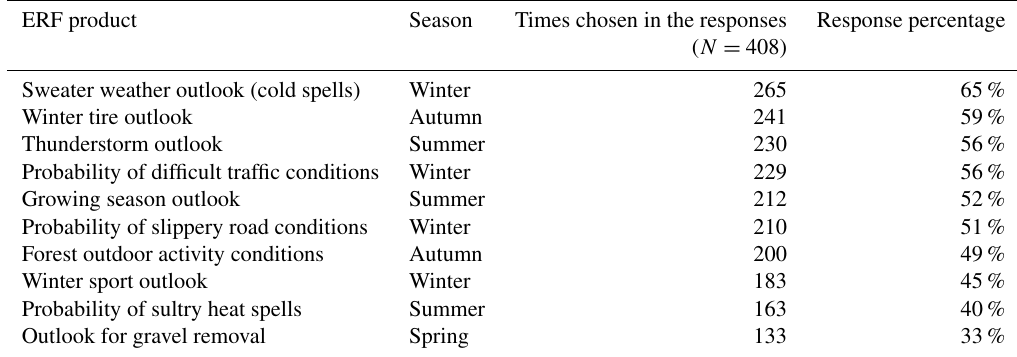
Table 3. The ten most popular products presented in the survey’s product portfolio ordered by popularity. ERF product Season Times chosen in the